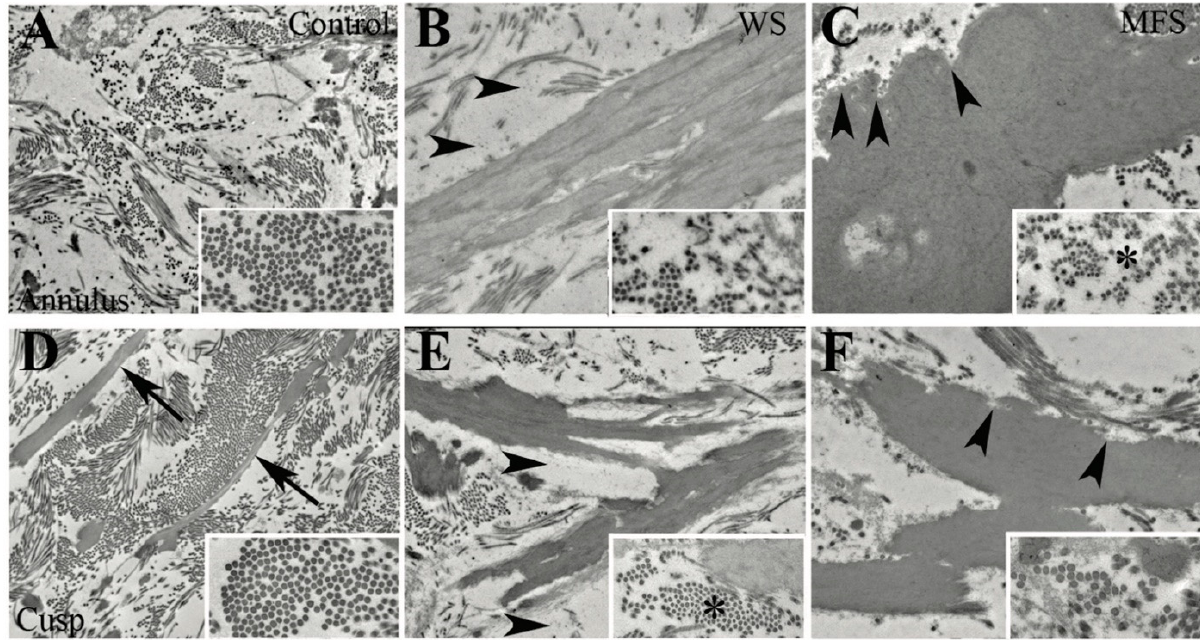
Figure 4. Ultrastructure of the valve annulus and cusp regions in WS and MFS. Collagen and elastic fiber organization in annulus ( A – C ) and cusp ( D – F ) regions from control ( A , D ), WS ( B , E ), and MFS ( C , F ) specimens. Cross sections of collagen fibril size and organization are demonstrated (insets). In control specimens, organized elastic fiber filaments are seen in the cusp (arrows) but not the annulus. WS specimens are characterized primarily by intra-EFF ( B , E ), whereas MFS has more inter-EFF (data not shown). There is proteoglycan accumulation in WS specimens (arrowheads, B , E ) and a “moth-eaten” edge appearance in MFS specimens (arrowheads, C and F ). Collagen fibrils are small, irregular, and decreased in number in the cusp region of WS and the annulus region of MFS (asterisks, C and E ).